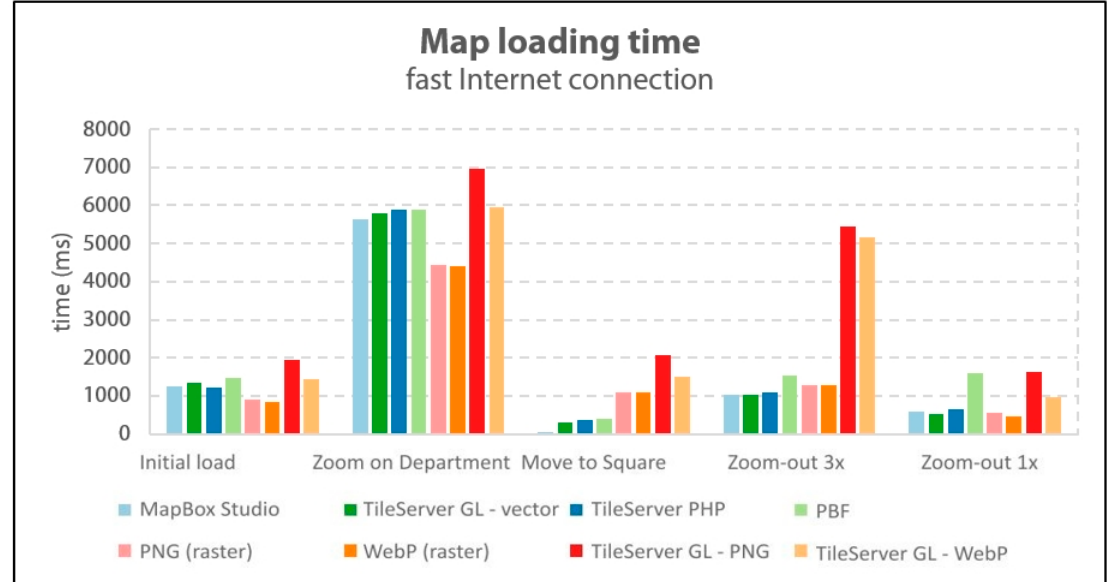
Figure 5. Results of map loading time (fast Internet connection).